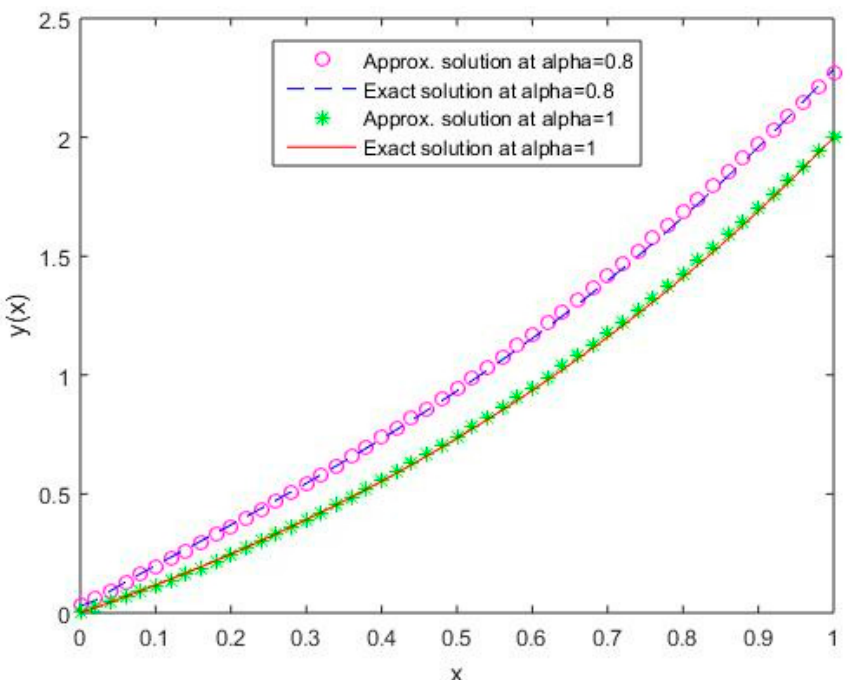
Figure 15. Comparison of exact and numerical solutions using S5 for 𝛼 = 0.8 and 𝛼 = 1 , Example 2.